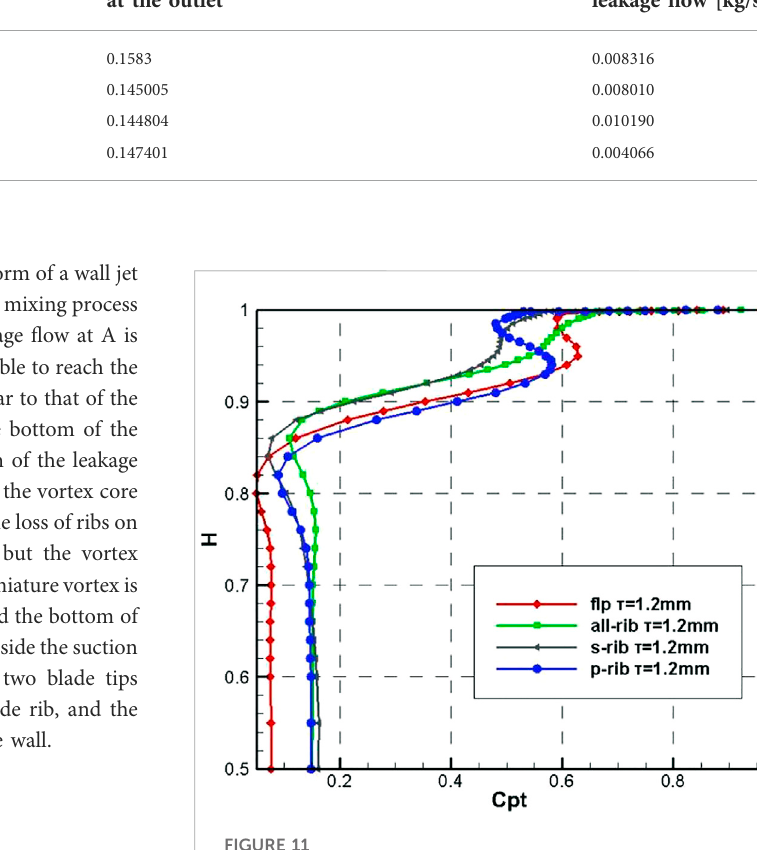
FIGURE 11 Average total pressure loss coef fi cient of pitch is distributed along the blade